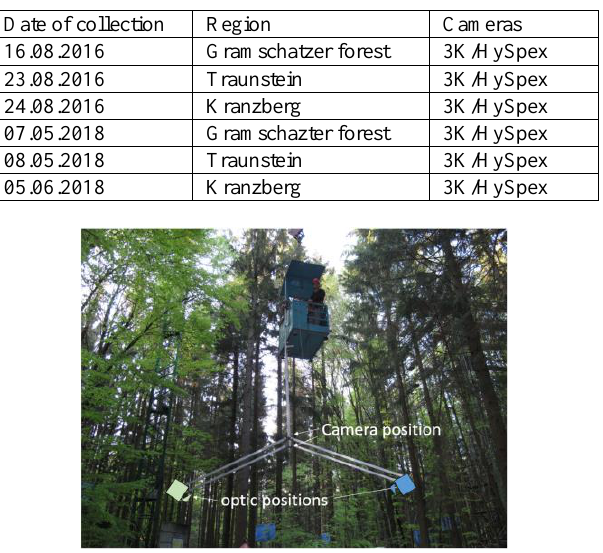
Figure 1. Kranzberg test site with GonioTree, 65° zenith angle position.